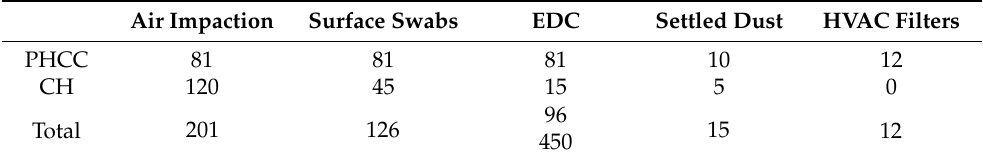
Table 1. Samples collected in the HCE analyzed by culture-based methods (Adopted from